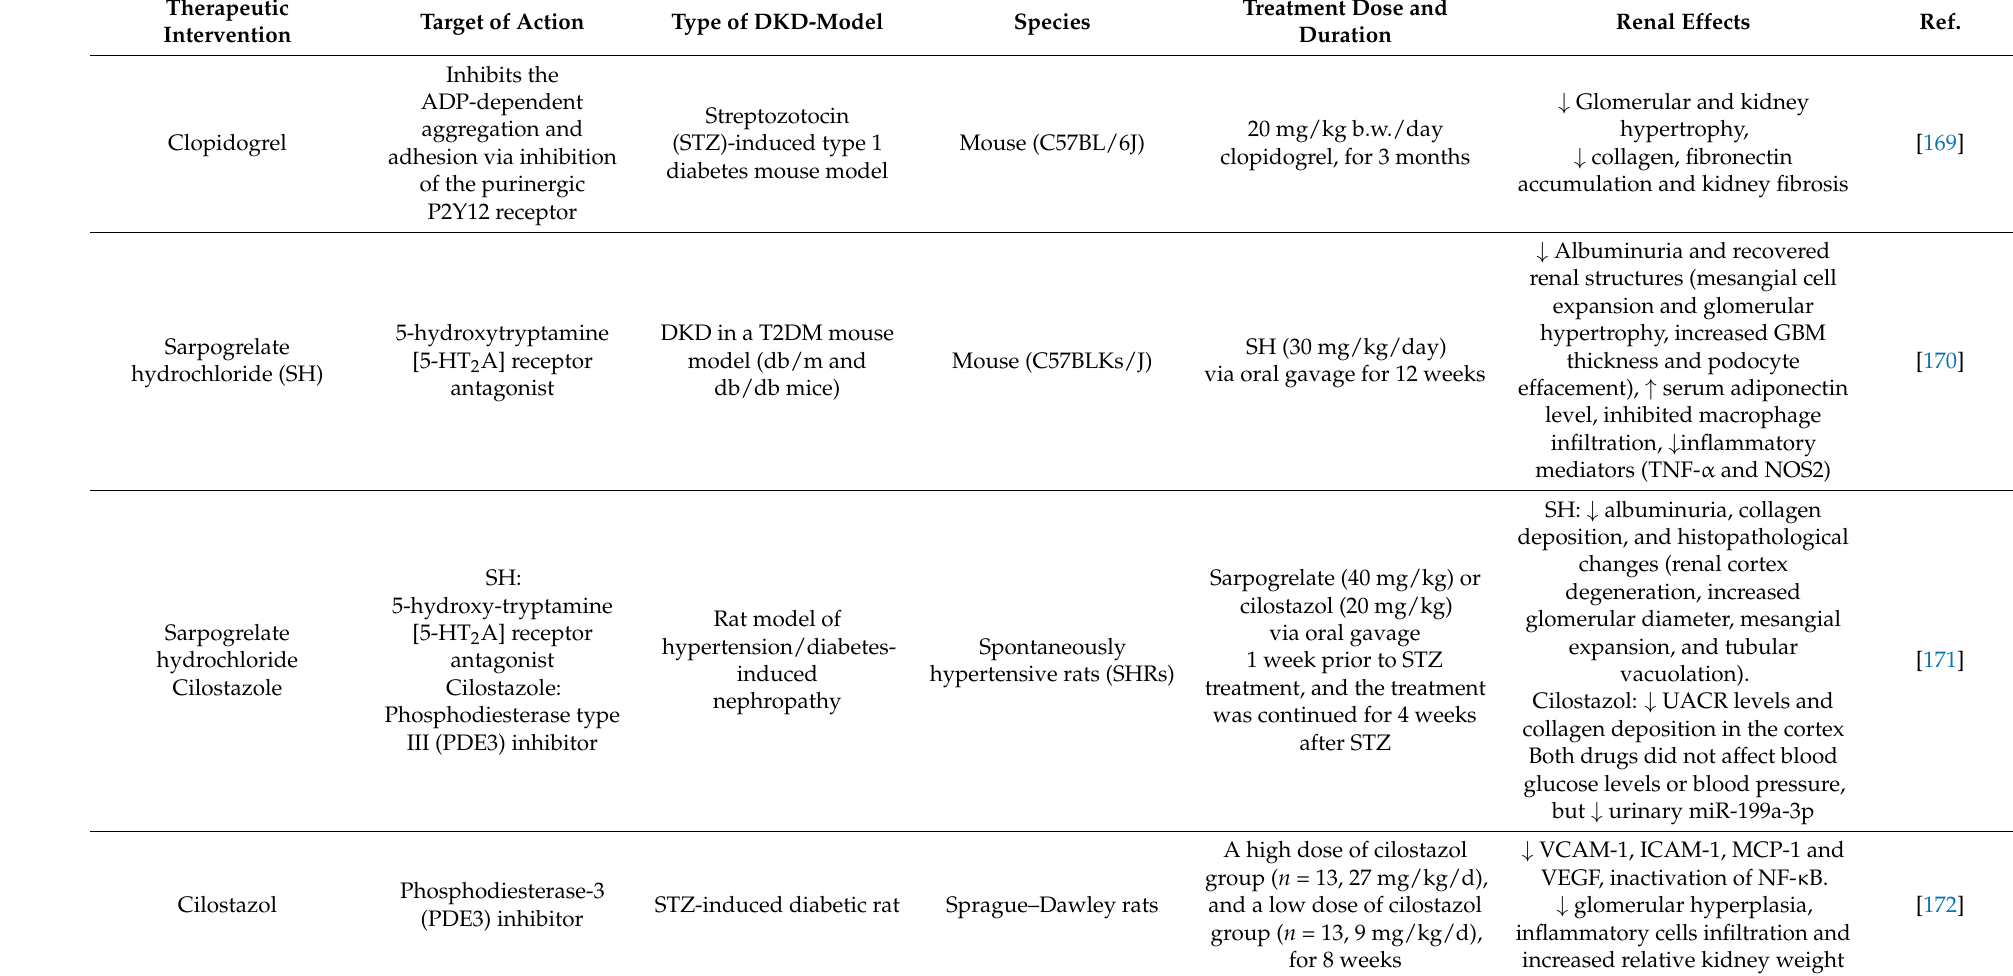
Table 3. Antiplatelets drugs therapy in animal models of